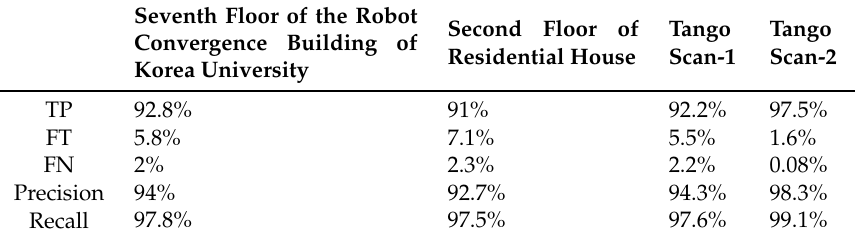
Table 3. Wall detection evaluation results.